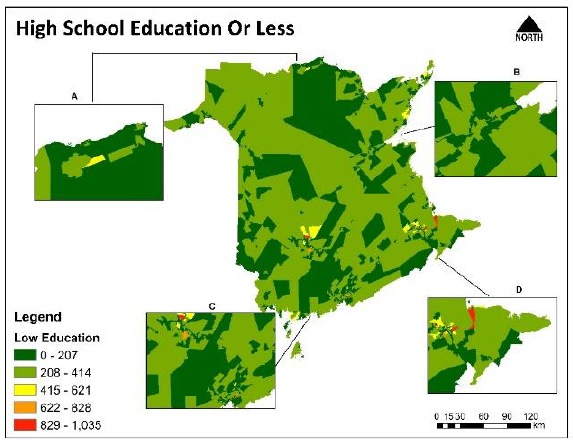
Geosciences 2020 , 10 , x FOR PEER REVIEW Figure A13. Population with High School Education Or Less. Figure A13. Population with High School Education Or Less. Figure A13. Population with High School Education Or Less.